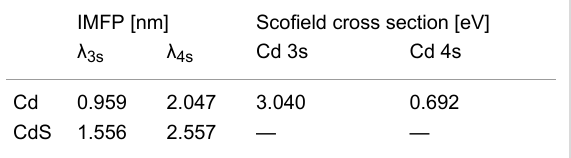
Table 2: XPS Parameters used in the Davis